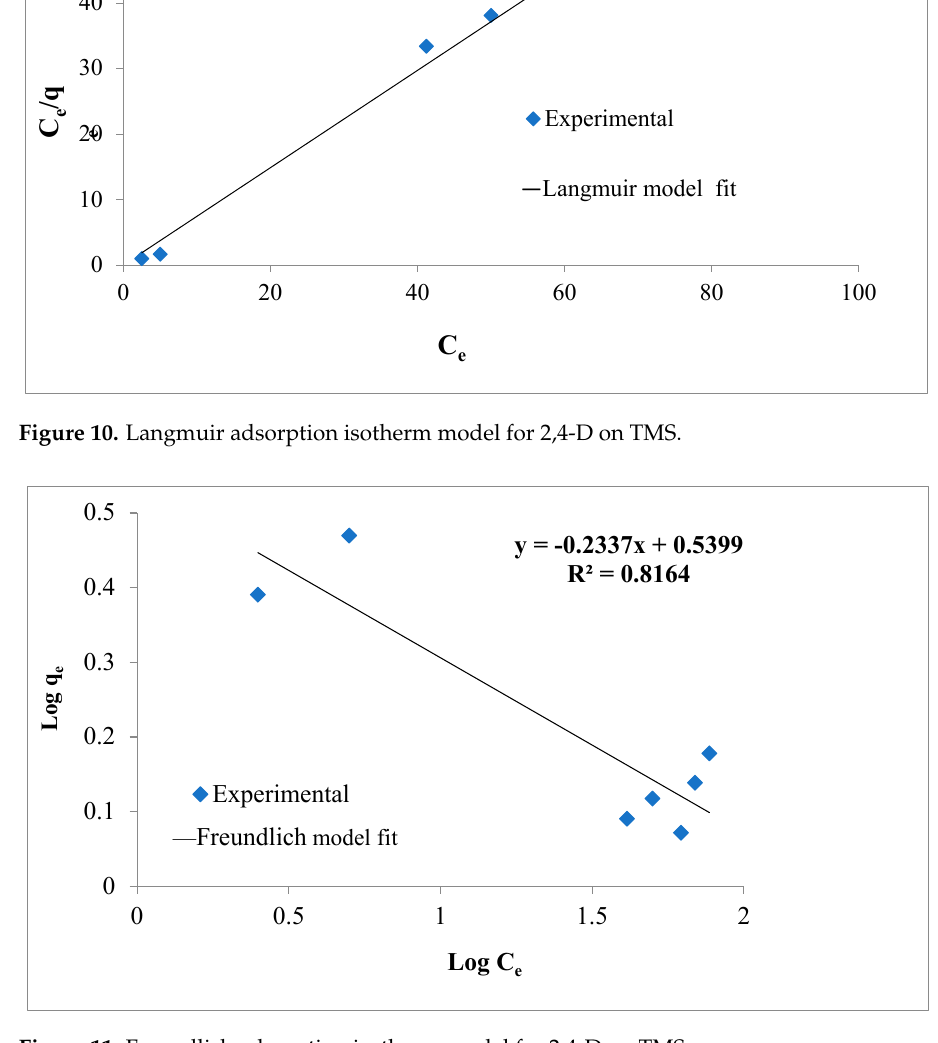
Table 5. Comparison of 2,4-D Langmuir adsorption capacities of different adsorbents.